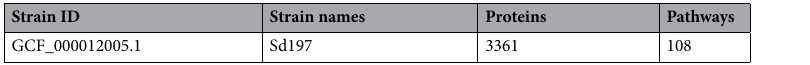
Table 1. Complete proteome of Shigella dysenteriae